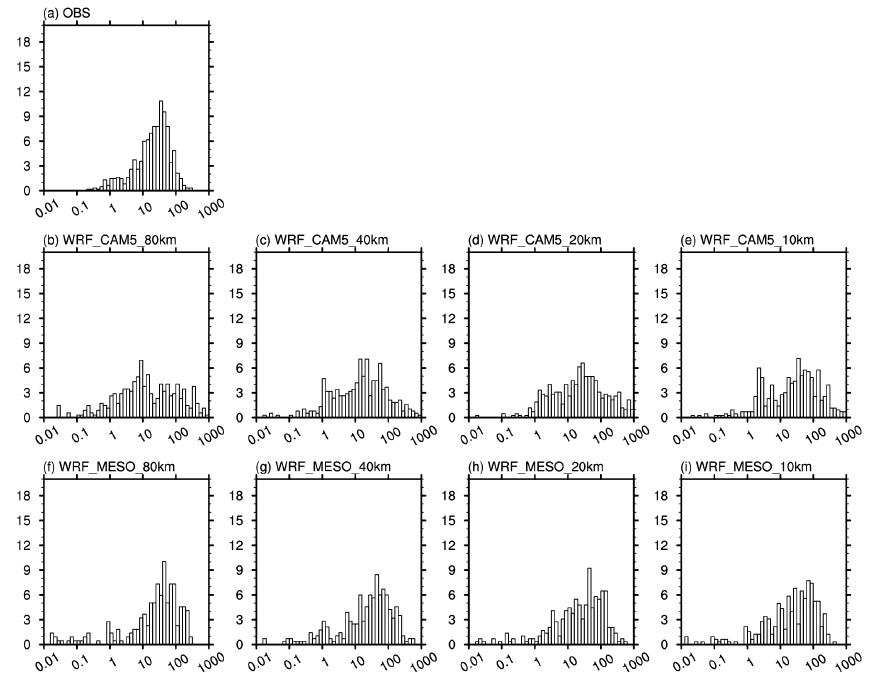
Fig. 16. Histograms (percentage) of (a) the observed liquid water path (gm − 2 ) from ARM Cloud Retrieval Ensemble Dataset, and (b) – (i) the simulated in-cloud liquid water path (gm − 2 ) from (b) – (e) WRF_CAM5 and (f) – (i) WRF_MESO simulations at Barrow.